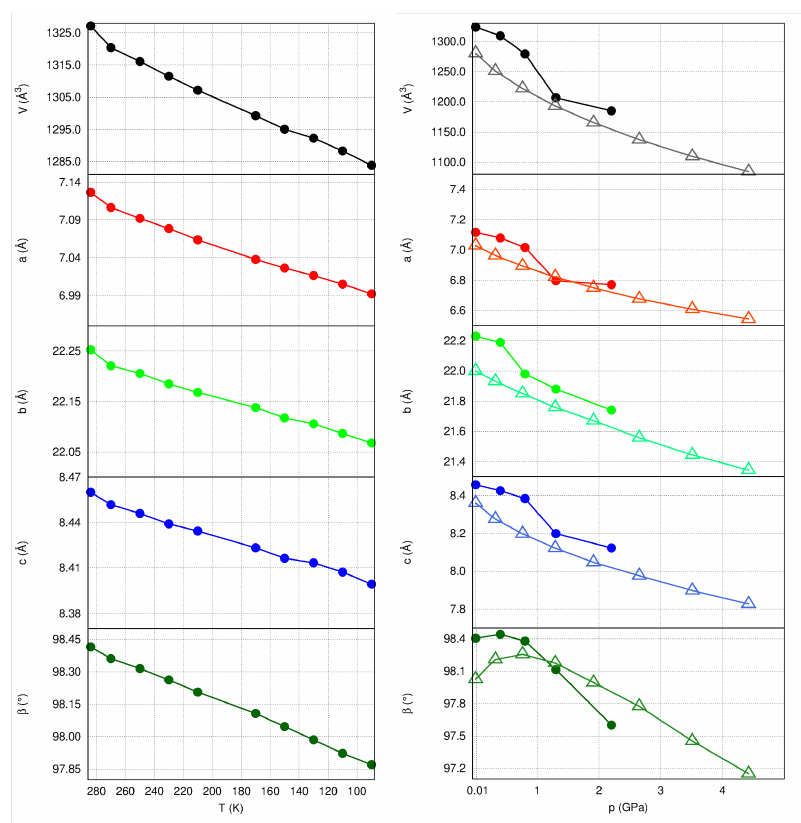
Figure 4. Unit cell parameter changes with temperature ( left ) and pressure ( right ). Experimental results represented by filled markers, results of theoretical calculations—as empty